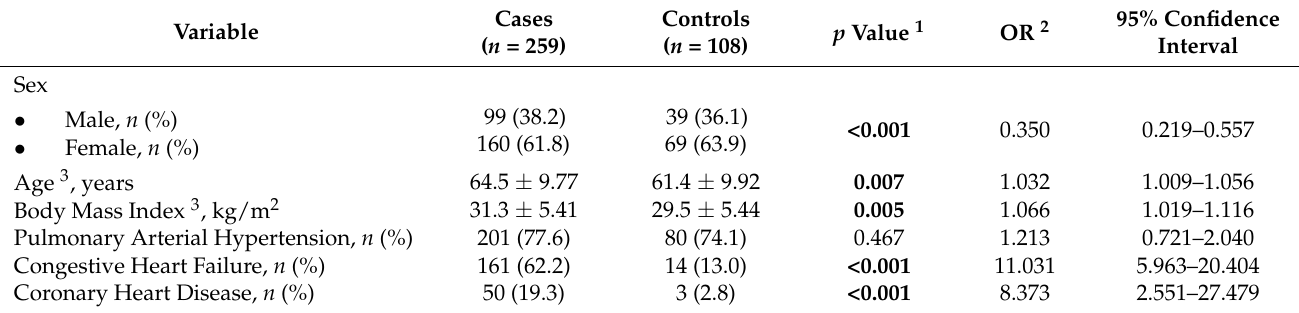
Table 2. Description of the case and control